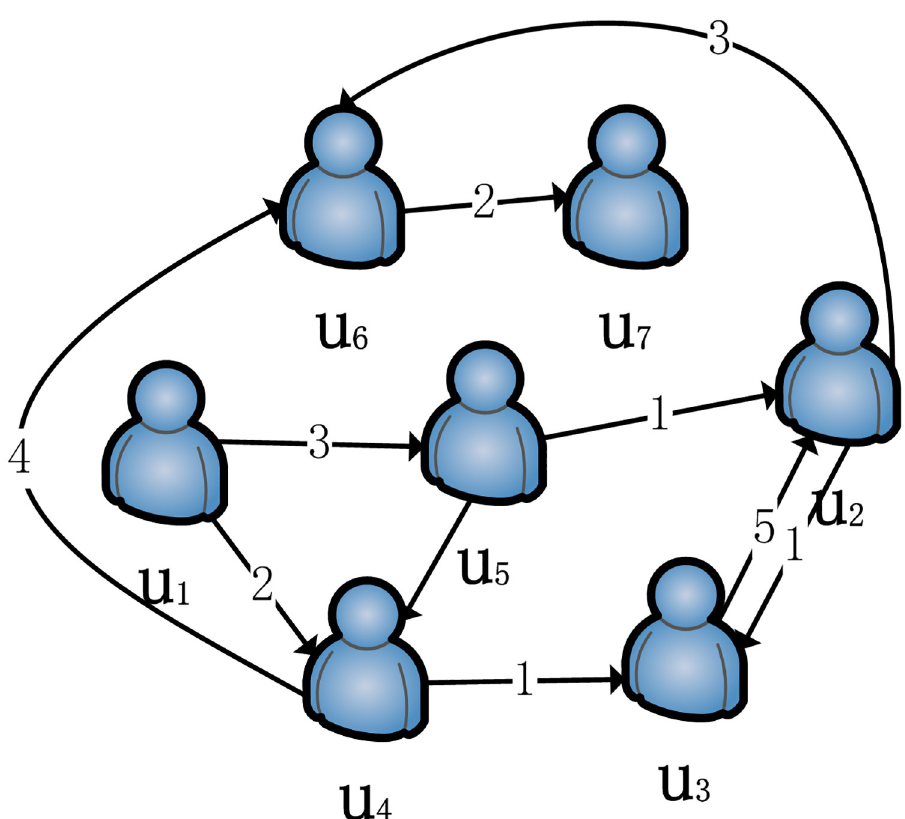
Fig 1. A simple social interaction